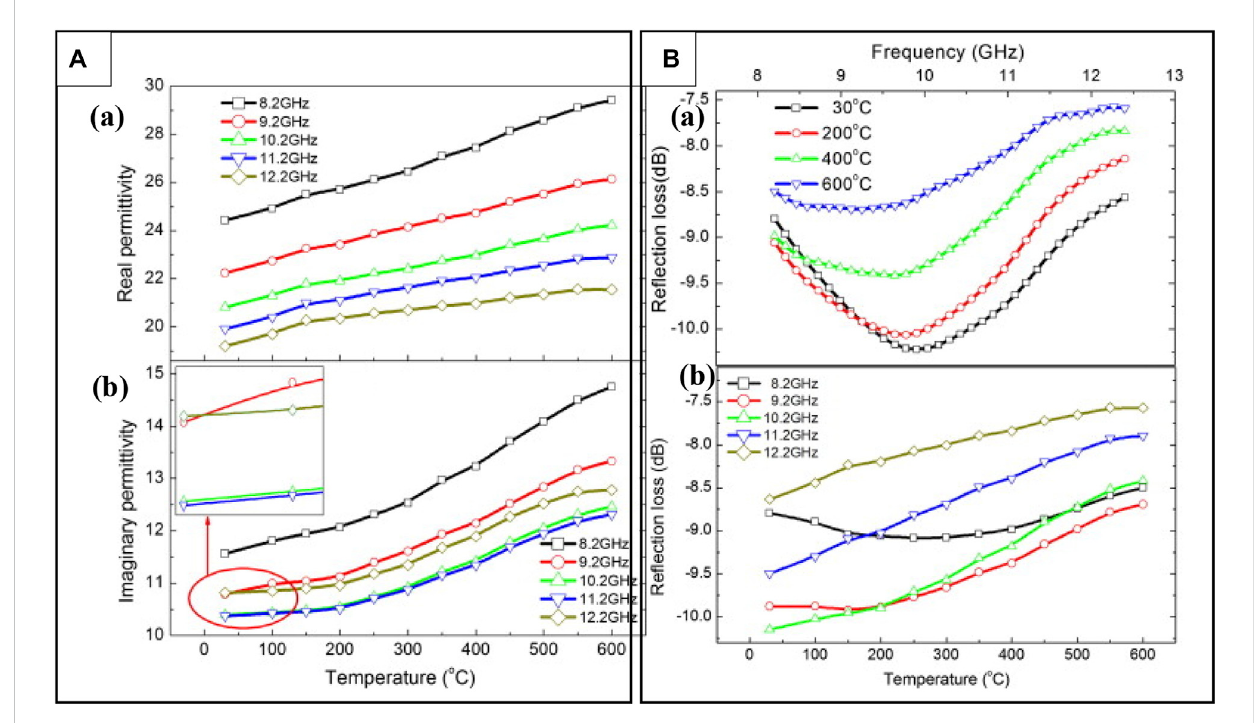
FIGURE 8 (Aa,b) Real and imaginary parts of the permittivity vs. temperature at various frequencies and (Ba,b) re fl ection loss vs. frequency and re fl ection loss vs. temperature related to the CF composite (Cao et al.,